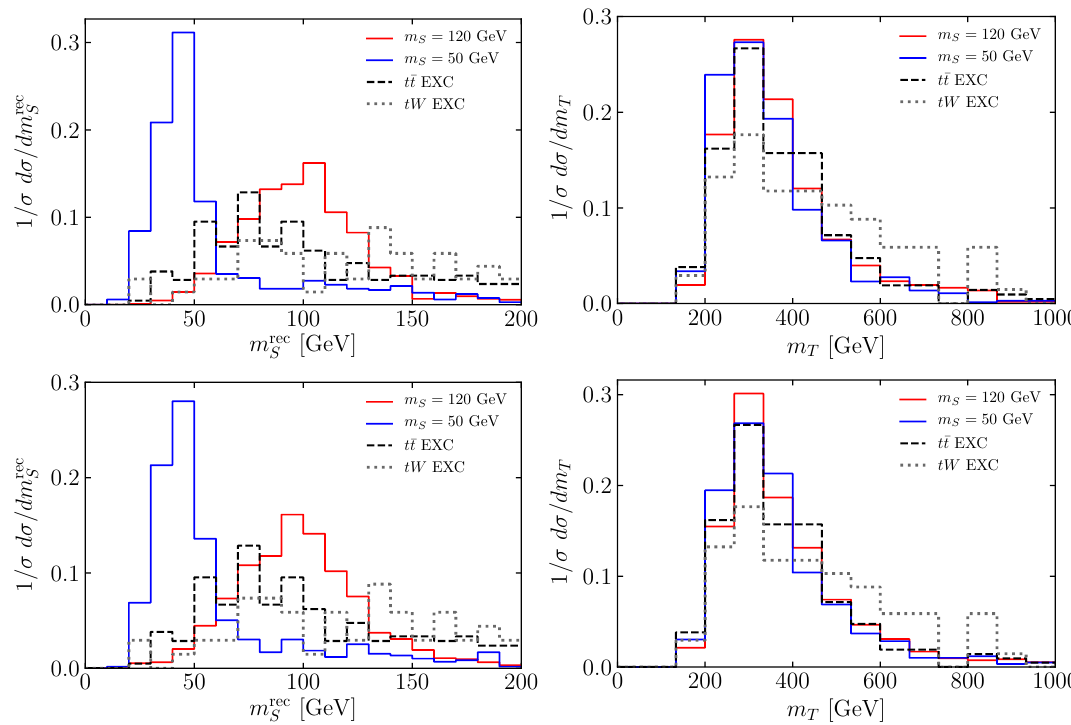
Figure 5 . The reconstructed scalar mass (left) and the transverse mass of the system composed by the lepton, the b -jet, the reconstructed S and missing energy (right) in the analysis proposed for t ! Sq , S ! (cid:28) + (cid:28) (cid:0) . In the upper (bottom) panel, q = c ( u ). We represent the distributions of two signal benchmark points and the two major background components, after the cut on the particle multiplicities; the background samples are generated exclusively, i.e. only gauge boson decays into taus are included. The distributions assume a collected luminosity of L = 150 fb (cid:0) 1